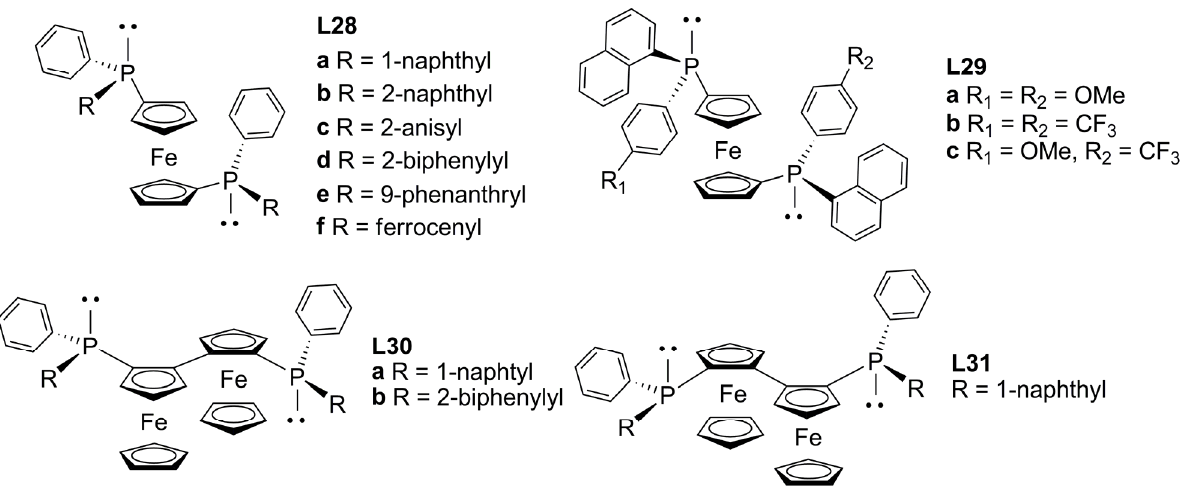
Figure 12. P-Stereogenic ferrocenyl diphosphines.